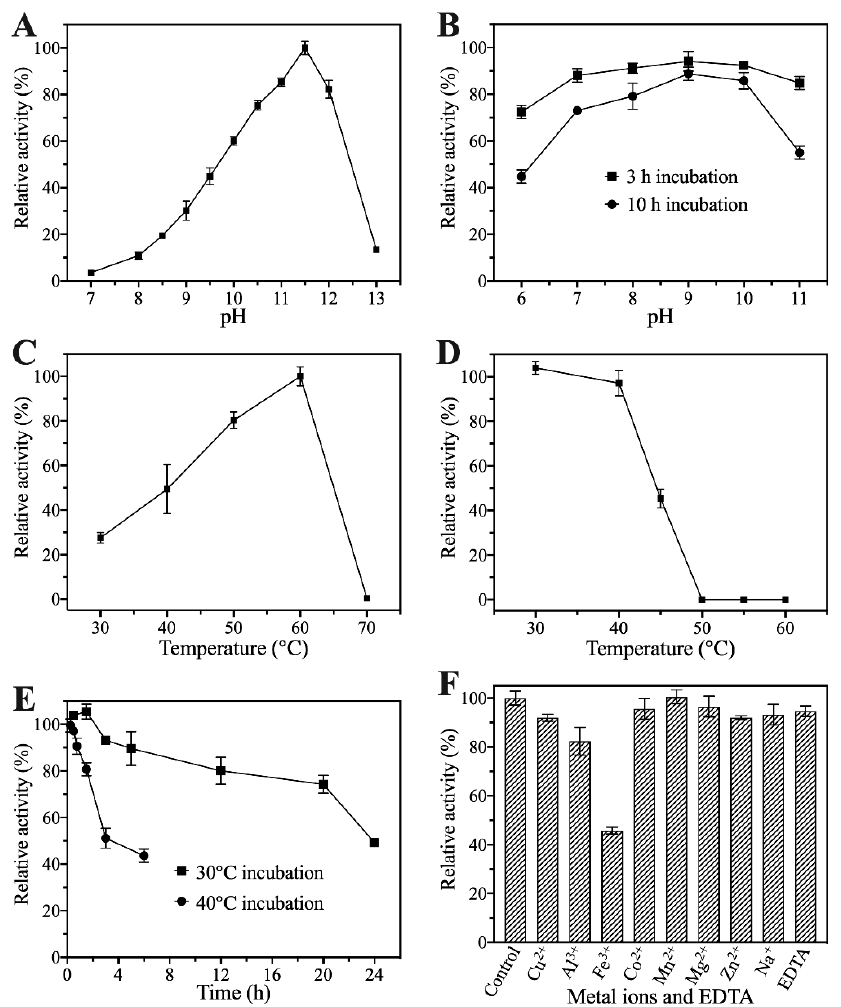
Figure 4. Biochemical characteristics of Pb LeuDH toward L-leucine. ( A ) Effects of pH on Pb LeuDH activity; the 100% value of relative activity was 46.82 U mg − 1 ; ( B ) Effects of pH on Pb LeuDH stability; ( C ) Effects of temperature on Pb LeuDH activity; the 100% value of relative activity was 93.14 U mg − 1 ; ( D ) Effects of temperature on Pb LeuDH thermostability after the incubation of the purified Pb LeuDH at temperatures 30 − 60 °C for 0.5 h; ( E ) Thermostability assays of Pb LeuDH under 30 °C and 40 °C; ( F ) Effects of metal ions on Pb LeuDH activity; the 100% value of relative activity was 26.43 U mg − 1 .